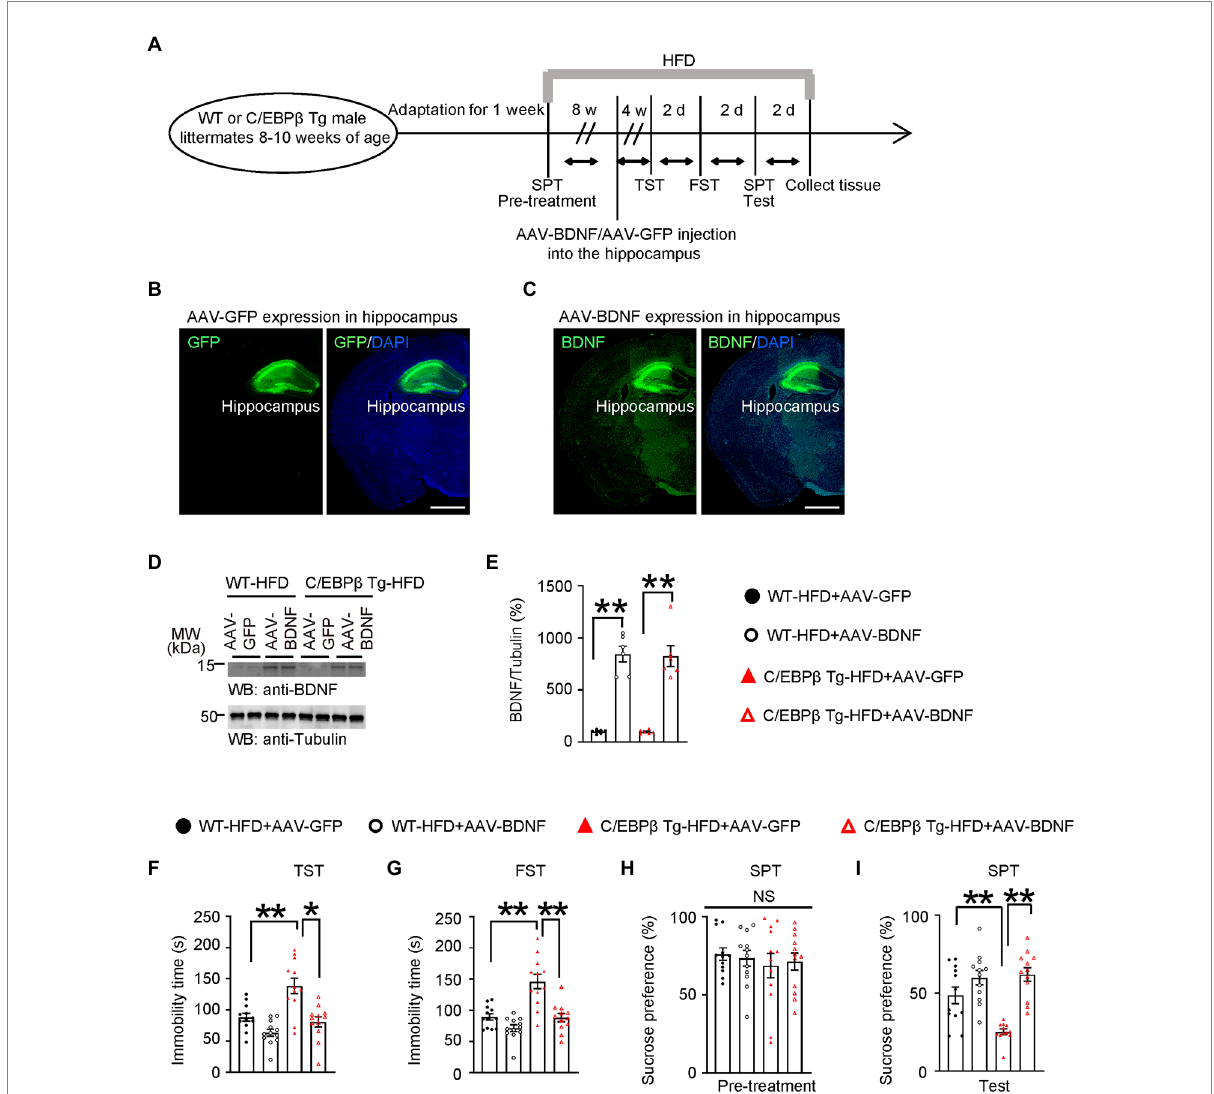
FIGURE 7 Overexpressing BDNF in the hippocampus alleviates HFD-induced depression-like behaviors in Thy1-C/EBP β Tg mice. (A) Schematic of the HFD or chow diet course, AAV-GFP/AAV-BDNF injection course, and behavioral tests process in wild-type and Thy1-C/EBP β Tg male mice. (B,C) Immunofluorescent staining of (B) GFP and (C) BDNF in the above mice. Scale bar: 800 μ m. (D) Representative immunoblots and (E) quantification of BDNF protein expression in the hippocampus from the above mice after AAV-GFP or AAV-BDNF injection. Data are representative of three independent experiments. Data in (E) represent the mean ± SEM ( n = 6 for each group; ** p < 0.01; one-way ANOVA and Bonferroni’s multiple comparison test). (F) Tail suspension test (G) forced swim test, and (H,I) sucrose preference test results for the above mice. Data represent mean ± SEM ( n = 12 mice for each group; * p < 0.05, ** p < 0.01; NS, not significant; one-way ANOVA and Bonferroni’s multiple comparison